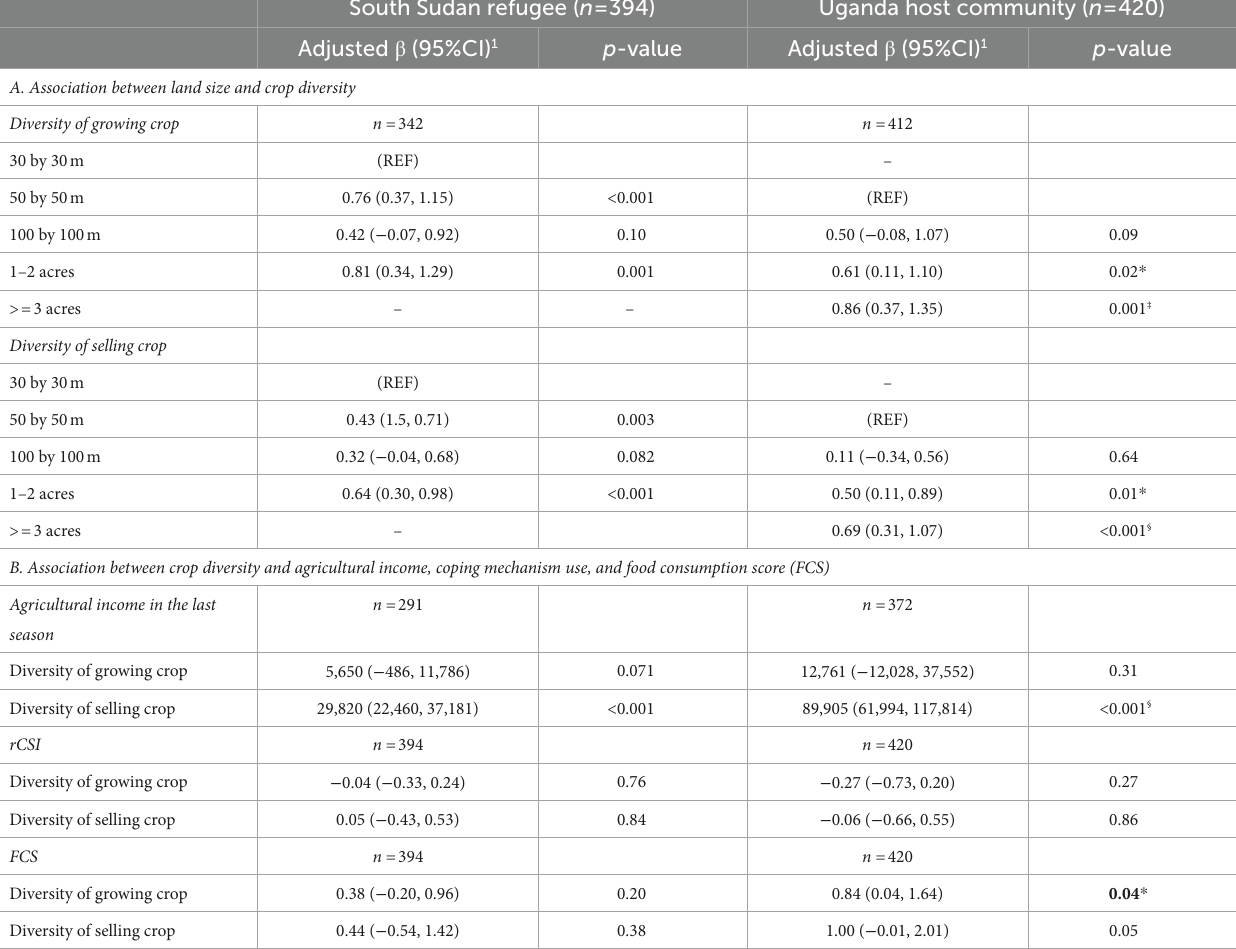
TABLE 4 Association between crop diversity and food consumption score (FCS), reduced Coping Strategy Index (rCSI), and agricultural income in the last season. South Sudan refugee ( n = 394) Uganda host community ( n =